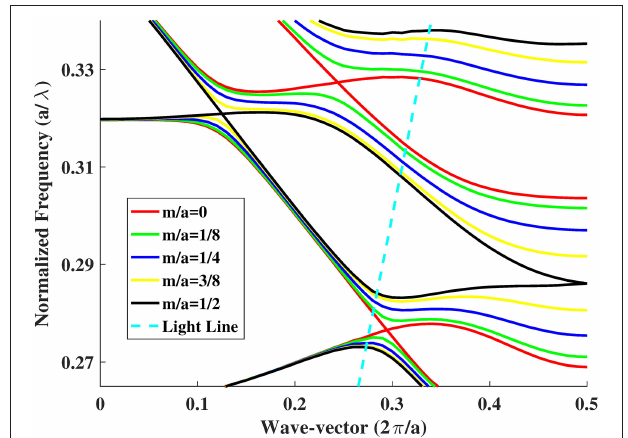
FIGURE 2 | Band structure of the PhC line-defect waveguide. Here, the air-hole period a is 450 nm, the air-hole radius is 0.29 a , and the waveguide width is 1.2 √ 3 a . Mode-crossing points exist for m / a 0. As m increases = (e.g., m / a 1 / 8,1 / 4,3 / 8,1 / 2), each mode-crossing point splits into two = modes (the upper and lower modes) and the split-mode spacing (or gap size) becomes large. The light line for the waveguide with upper and lower air-claddings is indicated by the slanted dashed